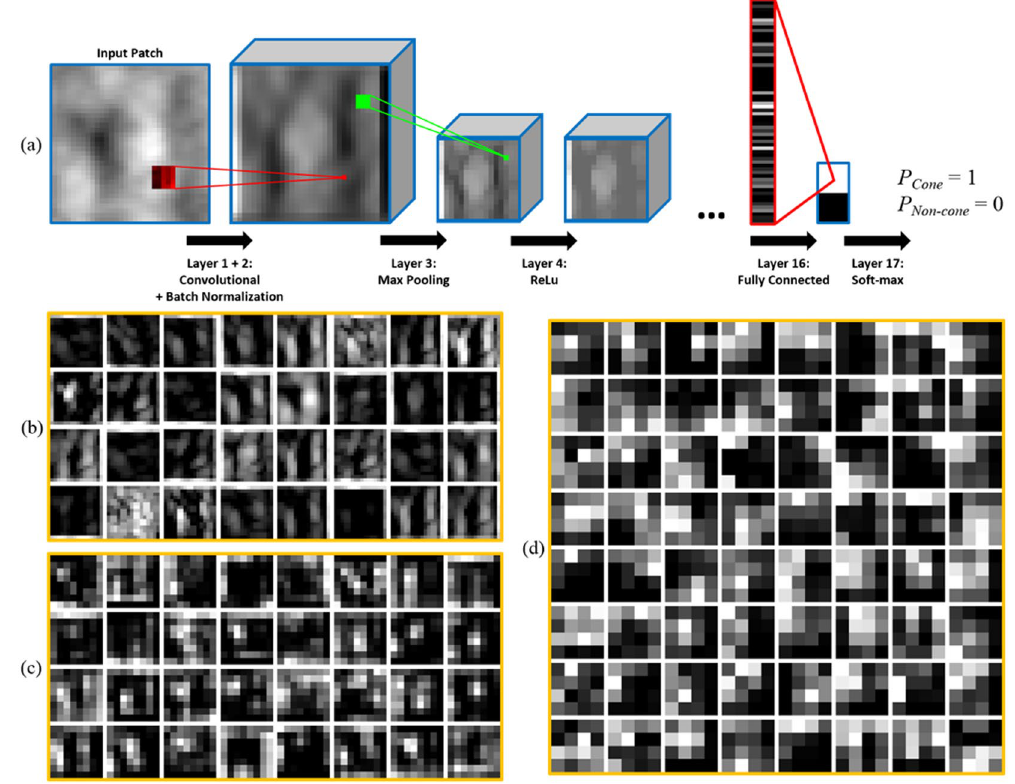
Figure 4. Convolutional network properties. ( a ) Visualization of convolutional, pooling, ReLu, fully connected, and soft-max layers. ( b – d ) Output feature maps from ( b ) Layer 4 ( c ) Layer 8, and ( d ) Layer 12 when the input patch from ( a ) is processed by the trained